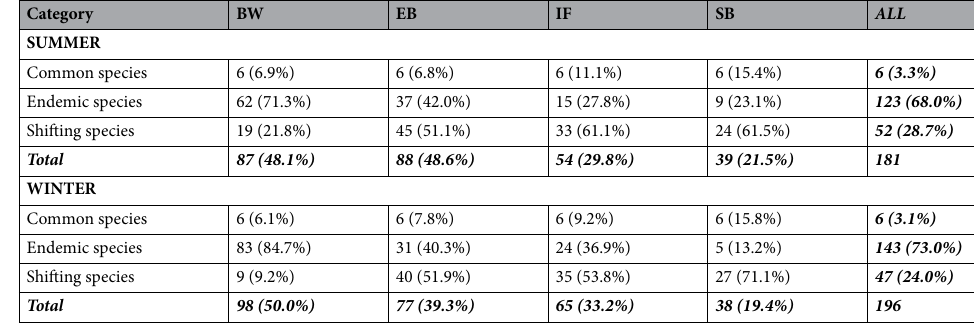
Table 1. The number of common, endemic, and shifting species in each habitat. Numbers in parentheses for the three species groups show species percentages relative to the total number of species in each habitat. Numbers in parentheses in rows marked Total are percentages relative to the total number of species across all habitats in each sampling time. Habitat abbreviations are as shown in Fig.